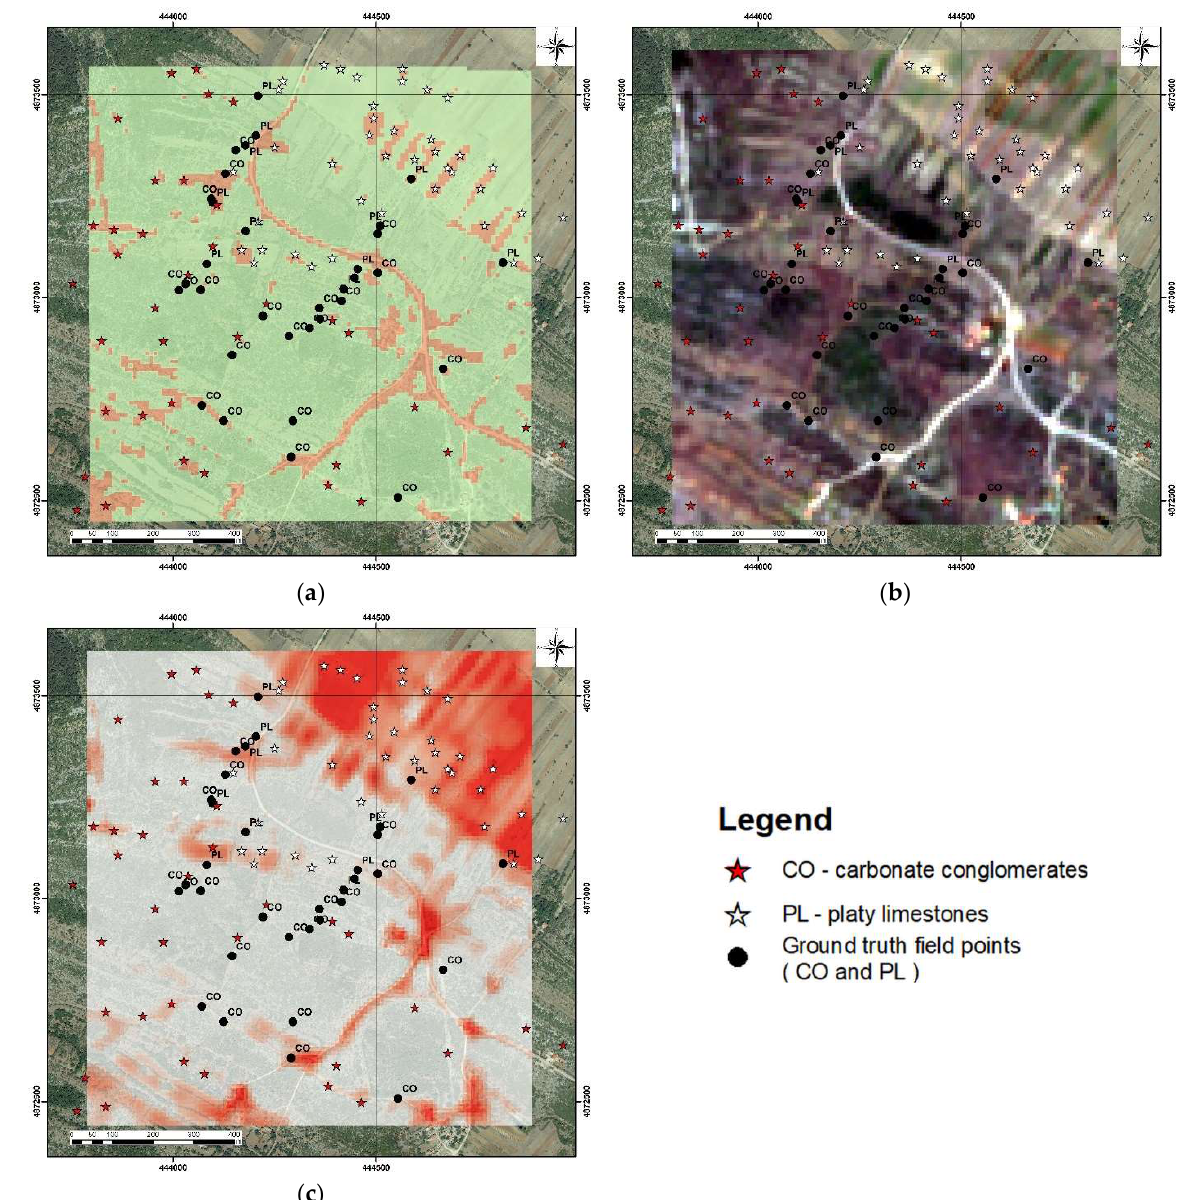
Figure 5. Selection points (pins) for spectral signature reading regarding Subset 2 site; ( a ) DOF is in the background. Green area represents vegetation, and orange area represents rocks and other landforms, all based on NDVI analysis; ( b ) RGB composite based on Sentinel 2-A imagery; ( c ) raster dataset derived from USGS spectral index on limestones.